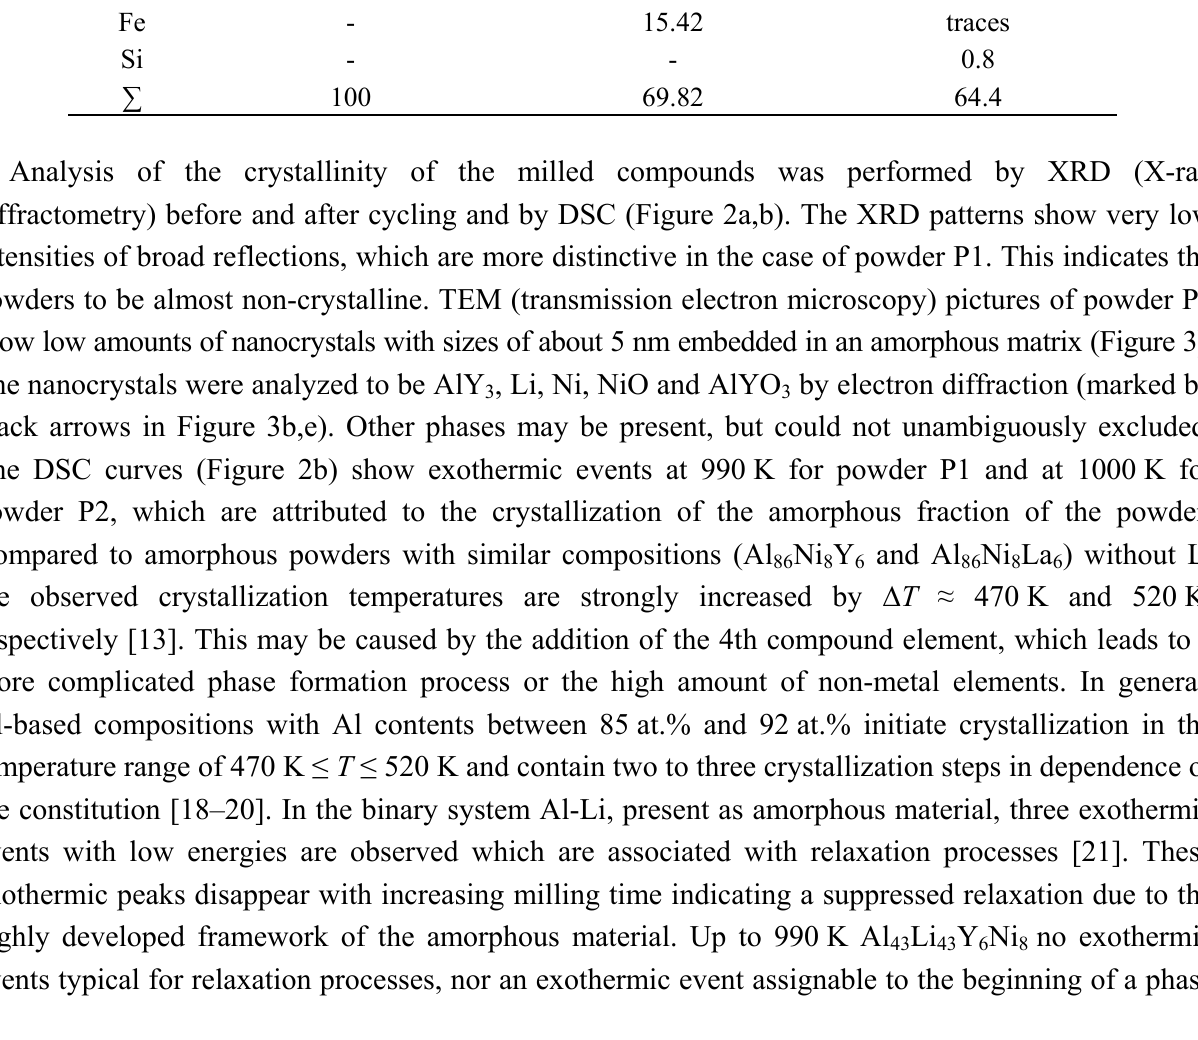
Li Ni Y powders. Since 43 43 8 6